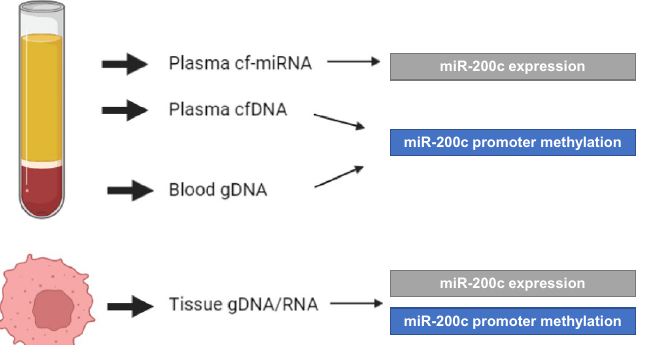
Figure 1. Study overview. Plasma cf-miRNA and cf-DNA was isolated from 125 study participants and analysed for miR-200c expression and promoter methylation analysis. Genomic DNA was obtained from whole blood (n = 110). Genomic DNA and RNA were simultaneously isolated from matched tissues (n = 46). This figure was created with Biorender.com and exported under a paid subscription.